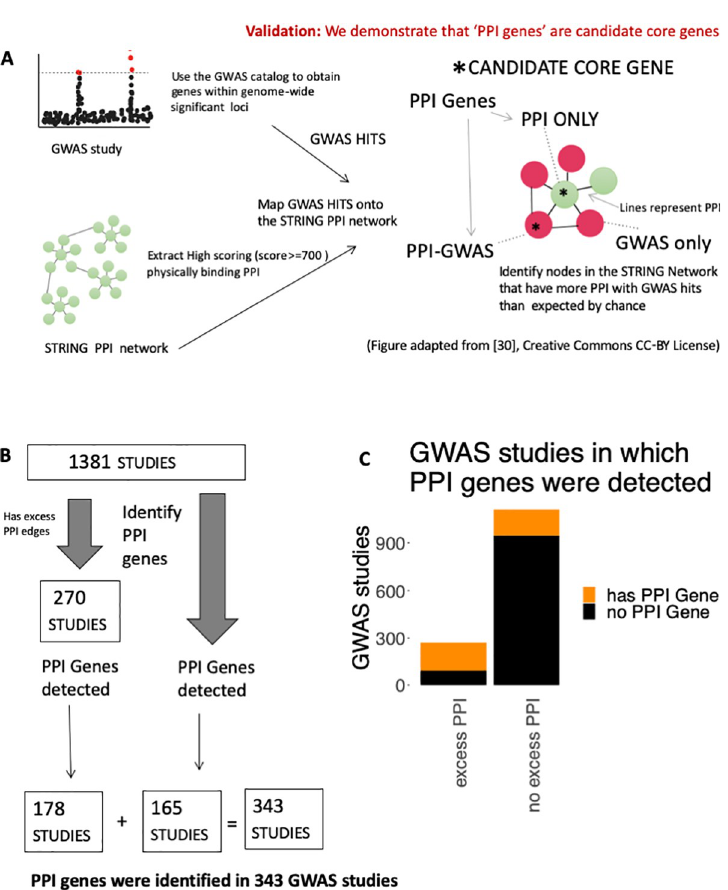
Fig 2. Identifying ‘PPI genes’ using nearest neighbor GWAS hits. (A) This figure was adapted from [30] (Creative Commons CC-BY license), it illustrates our method for detecting PPI genes. This method involves putting GWAS hits from the GWAS catalog onto the STRING PPI network, and identifying neighboring nodes that have excess PPI with the GWAS hits. We also define the following terms. ‘GWAS’: Genome-wide Association Study, ‘GWAS HIT’ Gene within genome-wide significant loci (p < 5x10 -8 ), ‘PPI’: Protein-Protein Interaction. ‘CORE GENE’: Gene with direct roles in disease biology ‘CANDIDATE CORE GENE’: Gene identified by our method that is likely to be a core gene. ‘PPI Gene’: PPI only or PPI-GWAS gene, ‘GWAS ONLY’: GWAS hit that is not a PPI gene. ‘PPI-GWAS’: PPI gene that is also a GWAS hit. ‘PPI only’: PPI gene that is not a GWAS hit. ‘All’: all 11,049 nodes within the STRING network. (B) Schematic demonstrating how we detected PPI genes in 343 Individual GWAS studies (178 of these studies had excess PPI between GWAS hits, while 165 studies did not show excess PPI among GWAS hits). (C) Proportion of studies with excess PPI that we also detect PPI genes in. Out of 270 studies in which we detect excess PPI amongst GWAS hits, we detect PPI genes in 178 studies. Amongst the remaining 1,111 GWAS studies, we detect PPI genes in 165